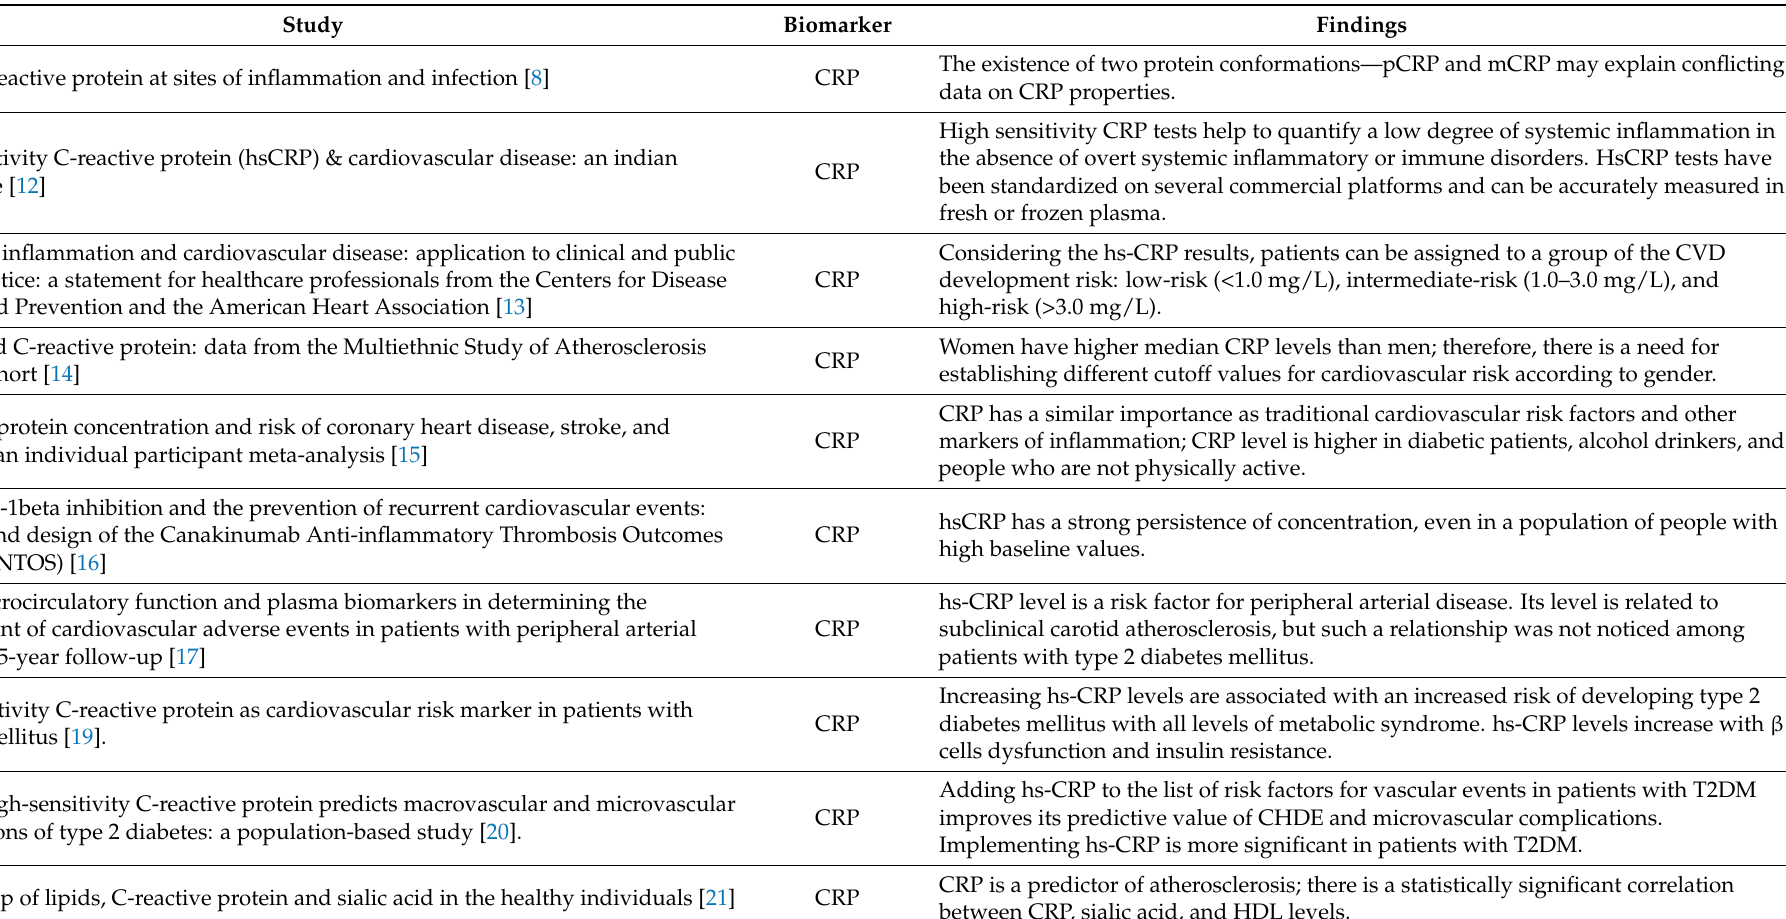
Table 1. Summary of findings about diagnosis and prognosis from studies concerning recognized cardiovascular